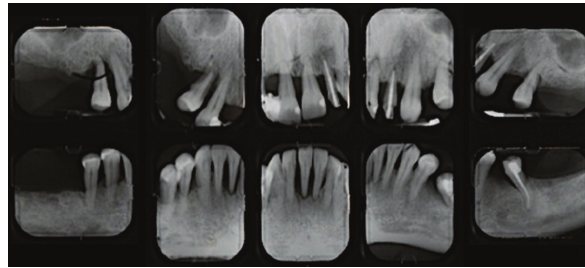
Figure 1: Pre-treatment periapical radiographs.